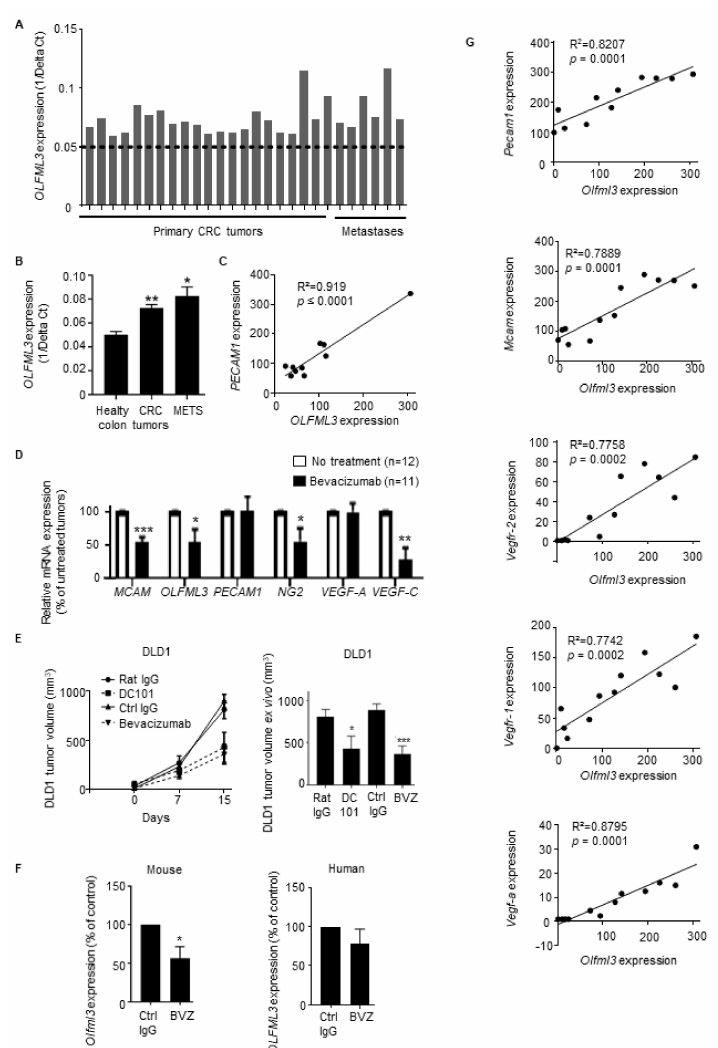
Figure 2. Expression of OLFML3 mRNA in primary CRC tissues, patient-derived xenografts (PDXs), and tumor transplan- tation models correlates with that of angiogenic factors and decreases after anti-VEGF therapy. ( A ) Relative expression of OLFML3 mRNA in PDX samples derived from primary CRC tumors ( n = 21) or CRC metastatic lesions ( n = 6) relative to the average expression level in healthy colon tissue (dotted line), as determined by qRT-PCR. The average CT value was calculated for both OLFML3 and the housekeeping gene EEF1; delta CT (CT, OLFML3-CT, EEF1) was determined. ( B ) Relative mean OLFML3 mRNA levels in the tissues described in ( A ). ( C ) Scatter plots with linear regression lines (black) showing the correlation between the expression of Olfml3 and PECAM1 mRNA in PDX samples ( n = 10), as determined by NanoString mRNA expression arrays. ( D ) Relative expression of mRNA encoding OLFML3 and angiogenic factors in tumor biopsies from CRC patients treated ( n = 11) or not ( n = 12) with bevacizumab, as determined by NanoString mRNA expression arrays. Results are normalized against values in nontreated patients. Bars represent the means ± SEM. ( E ) Growth of subcutaneous DLD1 xenografts ( left ) and size of excised tumors at the time of sacrifice ( right ) in immunodefi- cient NSG mice treated with an antihuman VEGF-A blocking mAb (bevacizumab), DC101, or the corresponding control IgG mAbs ( n = 6 mice per group). ( F ) Relative expression of mRNA encoding mouse Olfml3 (left) and human OLFML3 (right) in human DLD1 CRC tumor samples from NSG mice treated with either bevacizumab ( n = 6) or control IgG ( n = 6). Results are normalized against the values in nontreated mice. Bars represent the mean ± SEM; * p < 0.05. ( G ) Scatter plot with linear regression lines (black) showing the correlation between NanoString mRNA expression profiles of Olfml3 and levels of transcripts encoding mouse angiogenic factors (Pecam1, Mcam, Vegfr-2, Vegfr-1, and Vegf-a) in DLD1 tumor extracts ( n = 12), as determined by Pearson’s and Spearman’s rank correlation analyses. Differences between the groups were evaluated using the Mann–Whitney or unpaired Student’s t -test. Bars represent the mean ± SEM; * p < 0.05; ** p < 0.01; *** p <